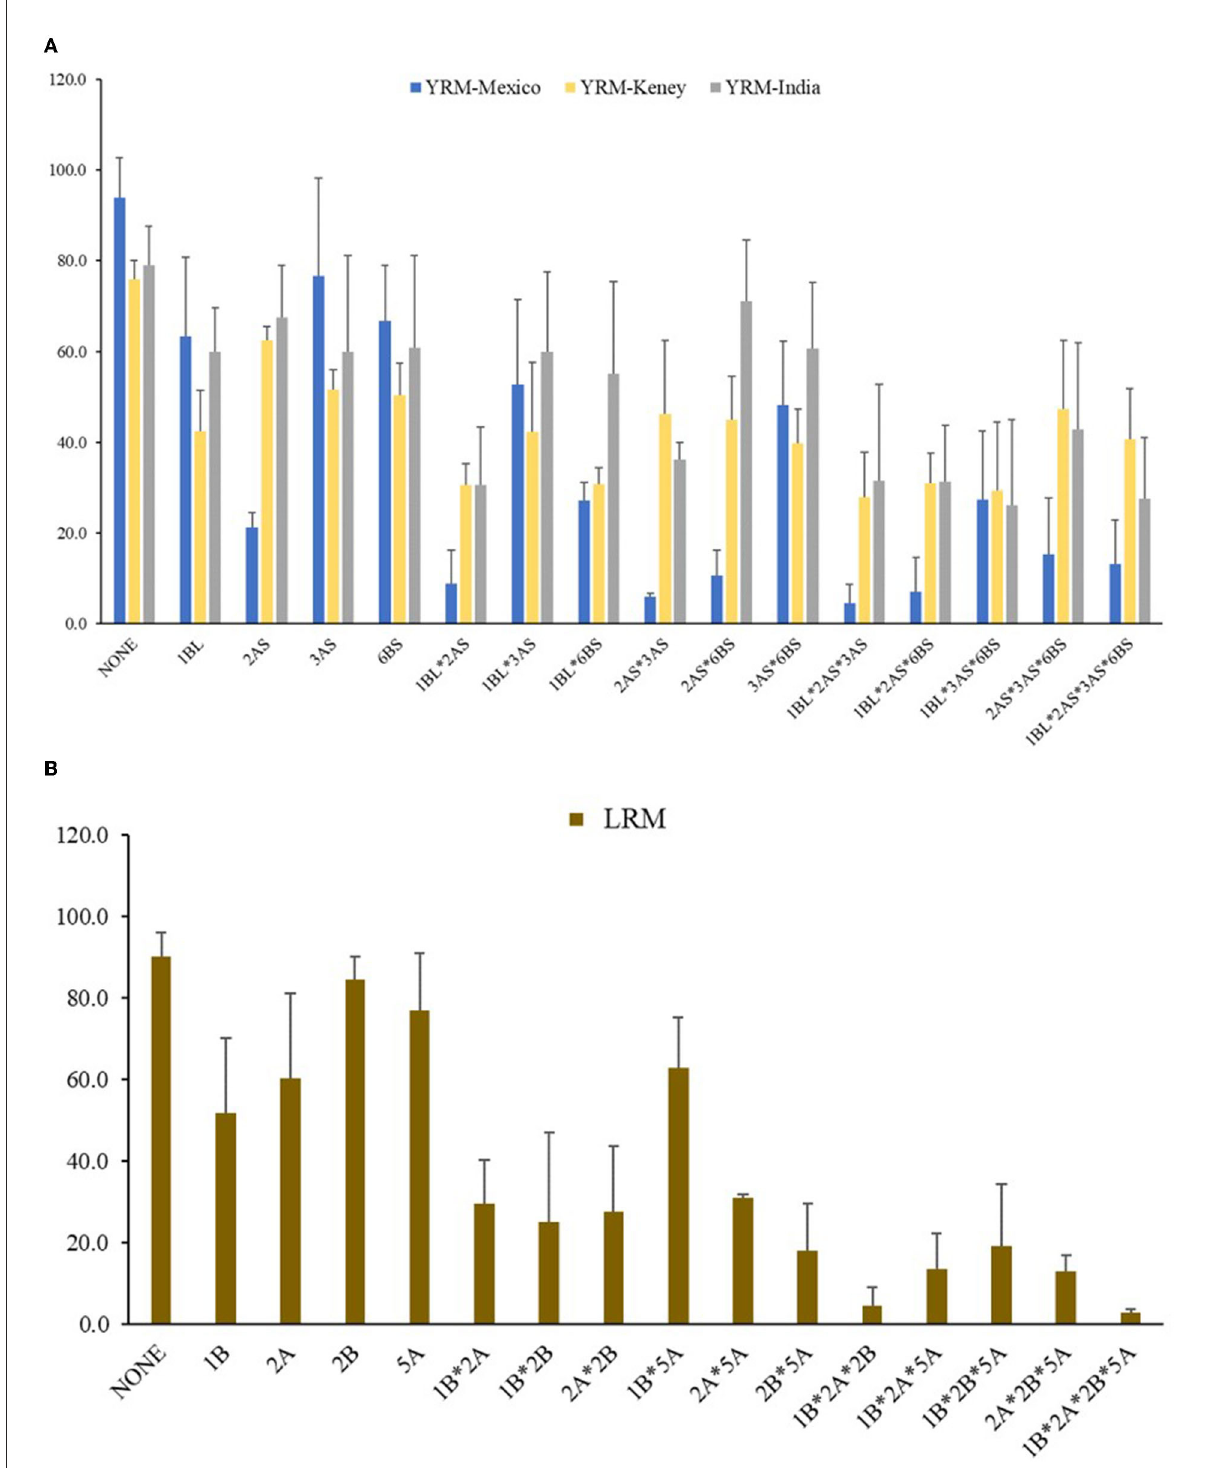
FIGURE4 Mean stripe rust severity in three counties (A) and leaf rust severity in Mexico (B) for lines carrying different QTL combinations, based on the flanking molecular marker of each identified locus from the Apav#1 × Mucuy F 5 RIL